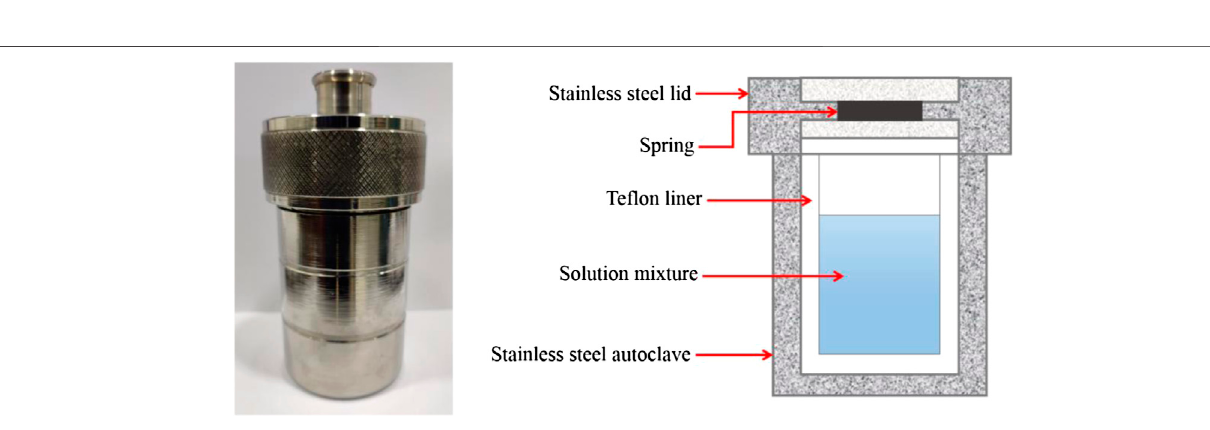
Frontiers in Materials |